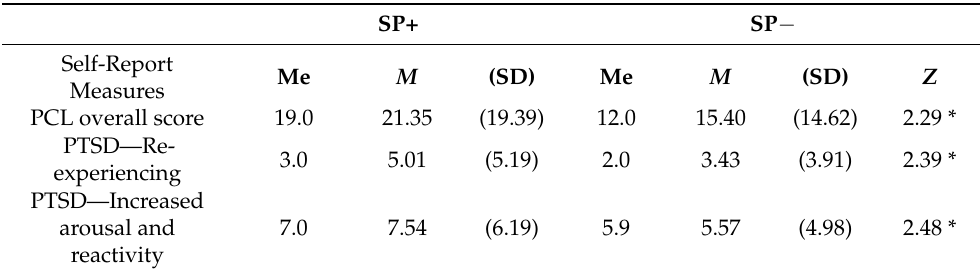
Table 2. Comparison of self-report measures for firefighters who experienced at least one SP in their lives and those who never experienced SP.